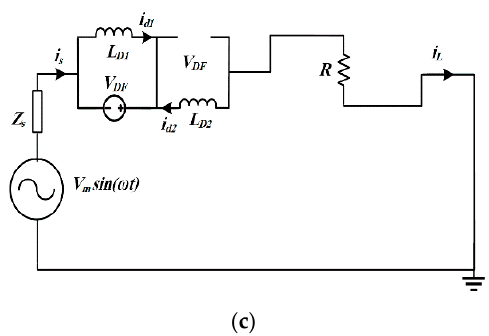
Figure 3. Equivalent circuit of MCFCL for ( a ) P 1 , ( b ) P 2 , and P 4 ( c ) P 3.